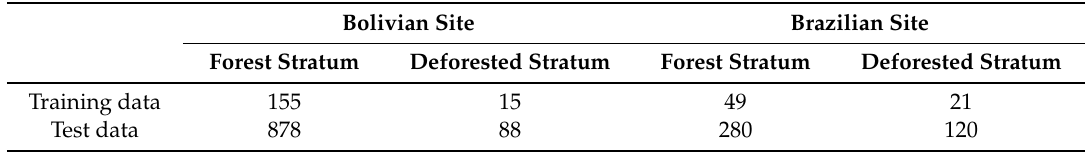
Table 2. Number of sample pixels used for training purposes and final validation of deforestation maps produced at the Bolivian and Brazilian sites.